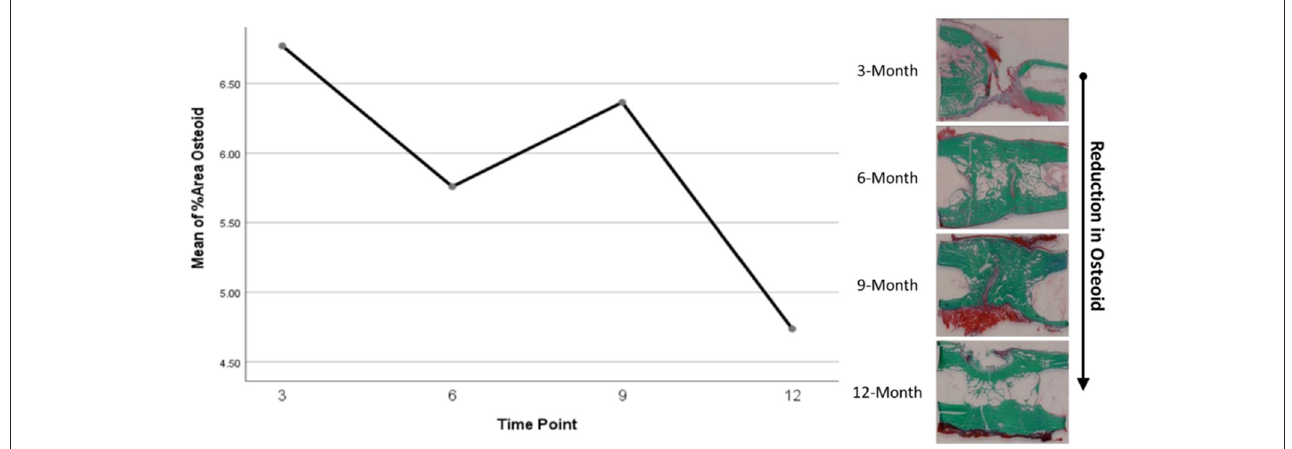
FIGURE6 Representative Goldner’s Trichrome histological staining and plotted osteoid content data.